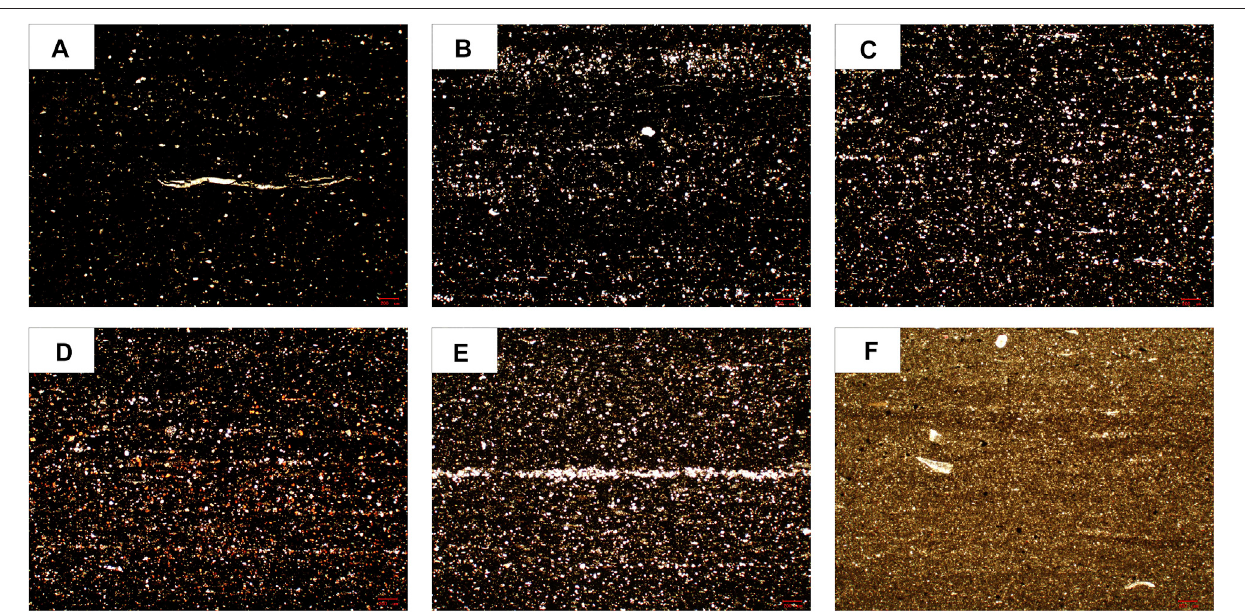
FIGURE4| Characteristicsofshaleofdifferentlithofaciesunderpolarizingmicroscope. (A) CM-1lithofacies,2983.78 m,wellL205; (B) M-2lithofacies,4016.32 m, well L205; (C) M-3 lithofacies, 4026.12 m, well L205; (D) S-3 lithofacies, 4029.97 m, well L205; (E) S-2 lithofacies, 4032.58 m, well L205; and (F) S-1 lithofacies, 4041.67 m, well L205.